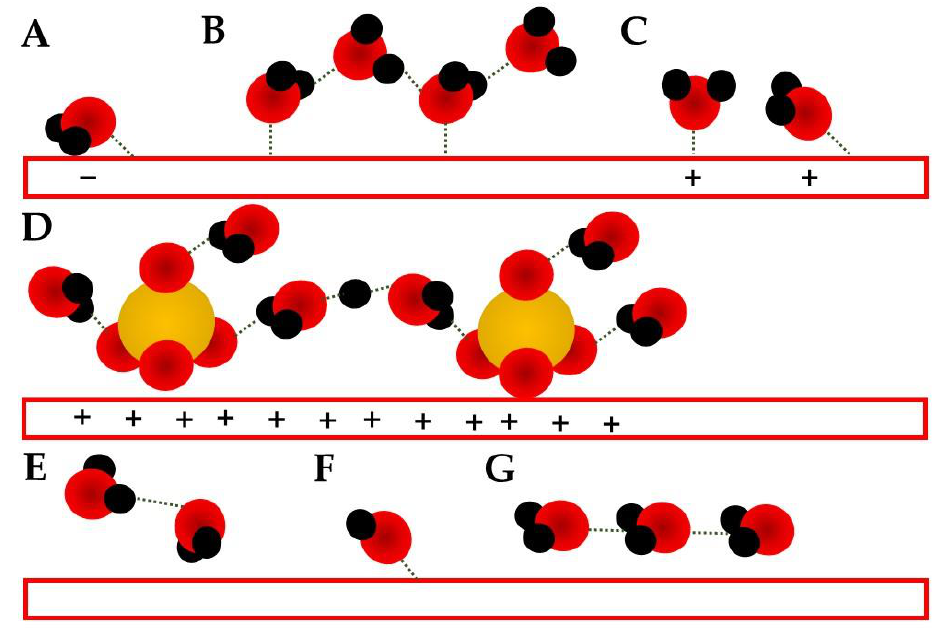
Figure 5. Schematics of water adsorbed structures on electrode surfaces (red rectangles). Red spheres represent oxygen atoms, black hydrogen, and yellow sulfur: ( A ) H-down conformation observed at potentials more negative than the PZC [7–9]; ( B ) “ice-like” bilayer structure observed around PZC [7–10]. ( C ) H-up conformation observed at potentials more positive than the PZC [7–9]; ( D ) solvated sulfate anions suggested for positive potentials [10]; ( E ) water dimer; ( F ) adsorbed OH − [133]; ( G ) flat adsorbed water at potentials around PZC [7,10].